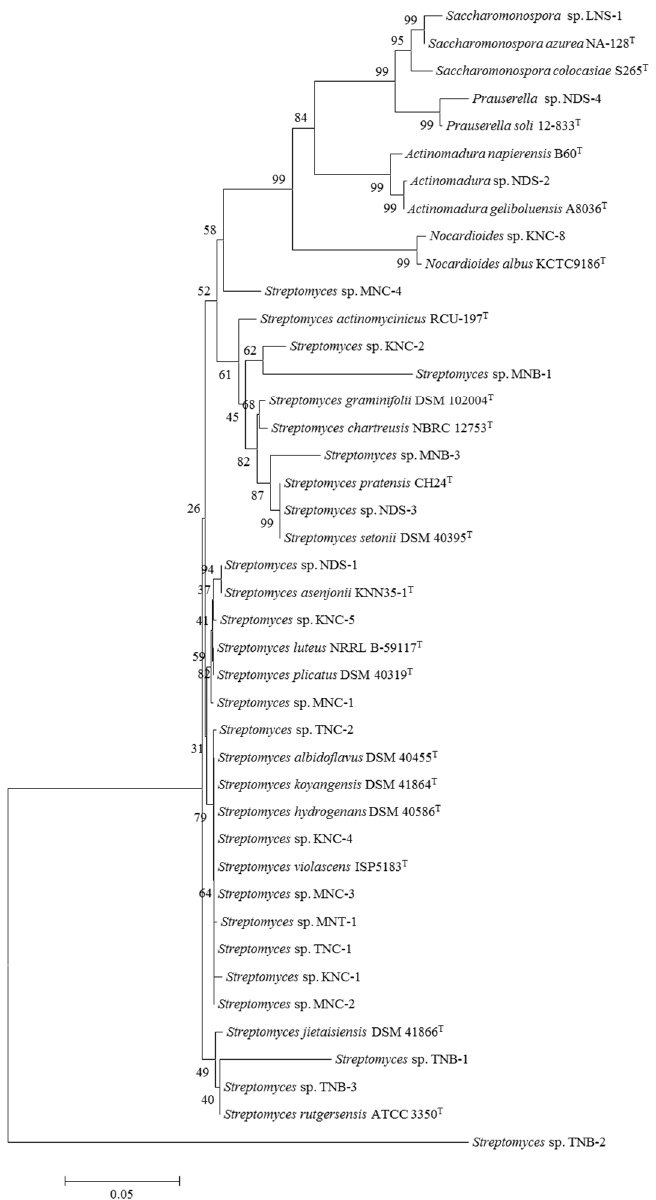
Figure 1. Neighbor-joining phylogenetic tree based on 16S rRNA gene sequences ( > 1300 nt) showing the relationships between 23 actinobacteria isolated from several Moroccan habitats and their closely related species. The numbers at the nodes indicate the levels of bootstrap support based on neighbor-joining analyses of 1500 resampled data sets. Bar, 0.05 substitution per nucleotide position.